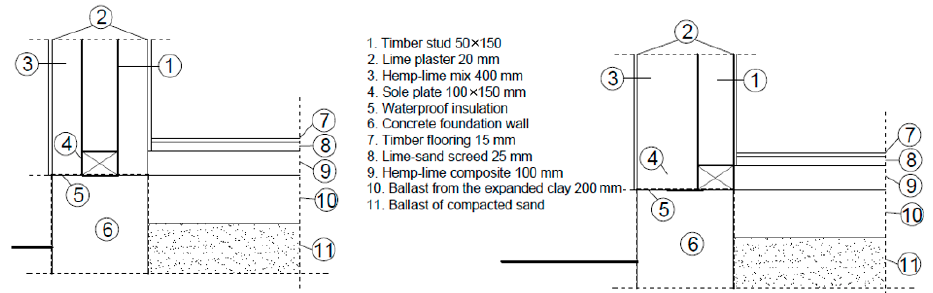
Figure 7. Connection of the wall and ground floor in two cases: with the timber frame located centrally in relation to the wall thickness (on the left ) and located on the inner side of the wall (on the right ).